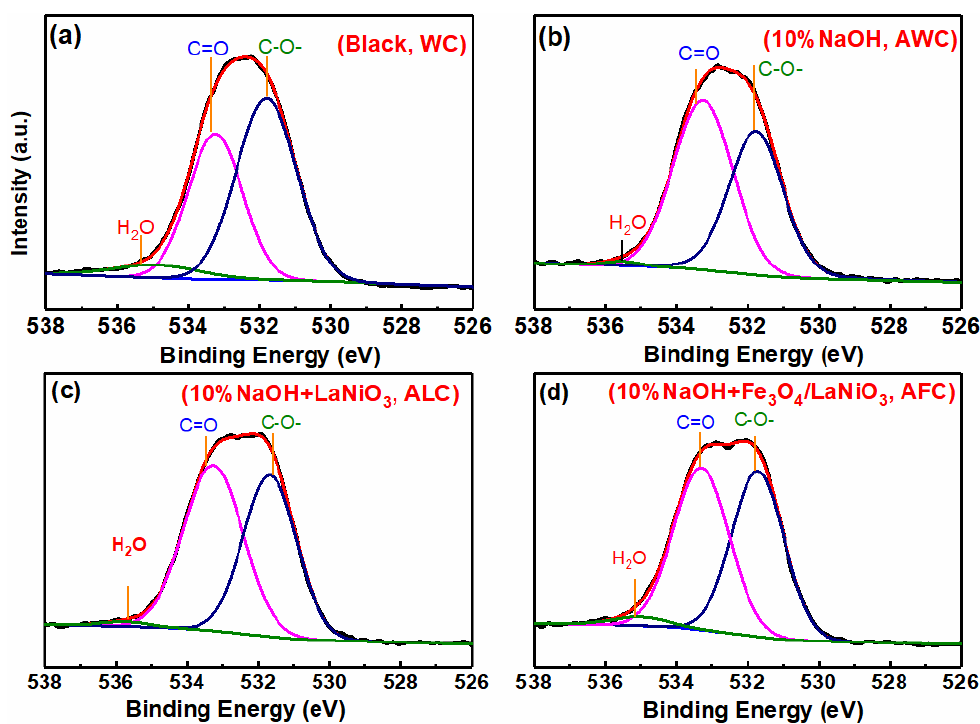
Figure 8. Four different treatments of humic acid XPS O 1s spectrum ( a ) WC, ( b ) AWC, ( c ) ALC, and ( d ) AFC.